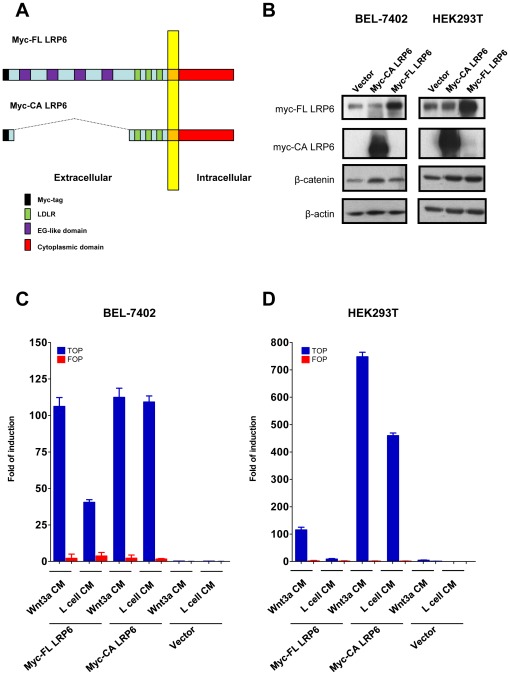
Ectopic expression of LRP6 activated the Wnt/β-catenin pathway.(A) Schematic diagram showing the structural domains of Myc-tagged full length form of LRP6 (myc-FL LRP6) and the constitutively active form (myc-CA LRP6). (B) Western blotting. Myc-FL LRP6 and myc-CA LRP6 were transiently overexpressed in BEL-7402 HCC cell line and human embryonic kidney cell HEK293T cells. The protein level of β-catenin was increased in both BEL-7402 HCC cell line and HEK293T cells. (C) TOP/FOP luciferase reporter assay. Expression of myc-FL LRP6 led to an activation of TCF/β-catenin reporter up to ∼40-fold (without Wnt3a treatment) and ∼120-fold (with Wnt3a treatment), respectively, as compared with the vector control. The fold of induction in myc-CA LRP6 cells reached ∼150-fold even without Wnt3a treatment. (D) Similar results were also observed in HEK293T cells.